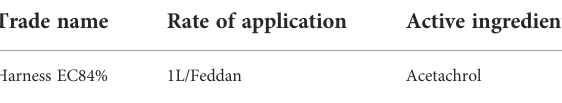
TABLE 1 Trade name, rate of application, and active ingredient of harness herbicide as a spray on the soil surface after planting and before